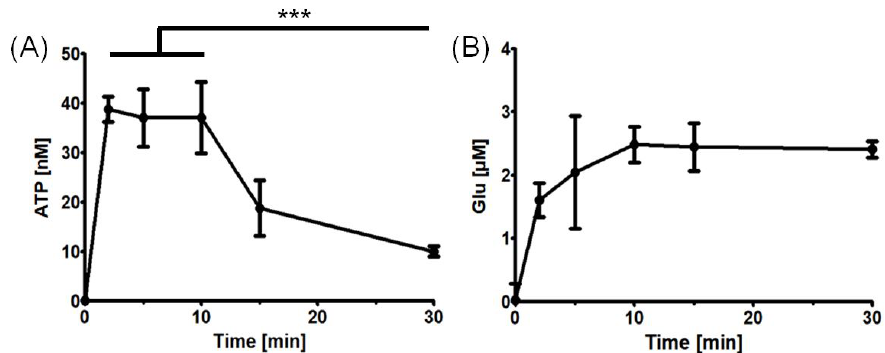
Figure 1. ATP and Glu release dynamics from the astrocyte cultures. ( A ) ATP release after cell wash and fresh experimental medium addition at various time points. ATP concentration was found to be significantly reduced at 30 min as compared with at 2–10 min (Welch’s t -test, *** p < 0.001). ( B ) Glu release after cell wash and HEPES - buffered solution addition at various time points. The points represent the mean estimates, whereas the whiskers indicate the standard errors of means. Number of biological replicates n ≥ 4 for each time point.